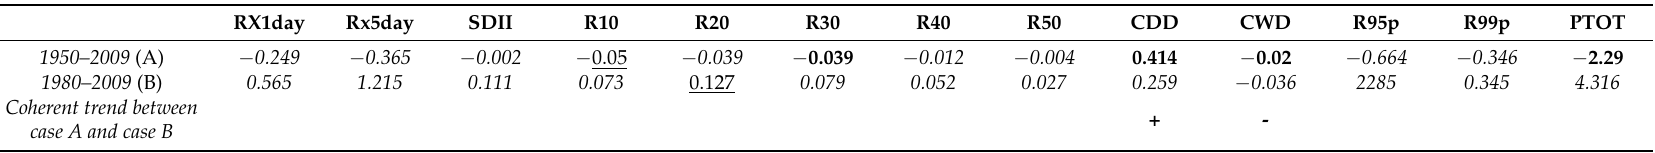
Table 6. Trends in annual precipitation indices at Niamey based on NAD-M_9 dataset (in italic values without statistical significance; in black underlined values with statistical significance at 10%, in bold values with statistical significance at 5%). Positive values report an increasing trend while negative values report a decreasing trend (see Table 2 for the definition of the